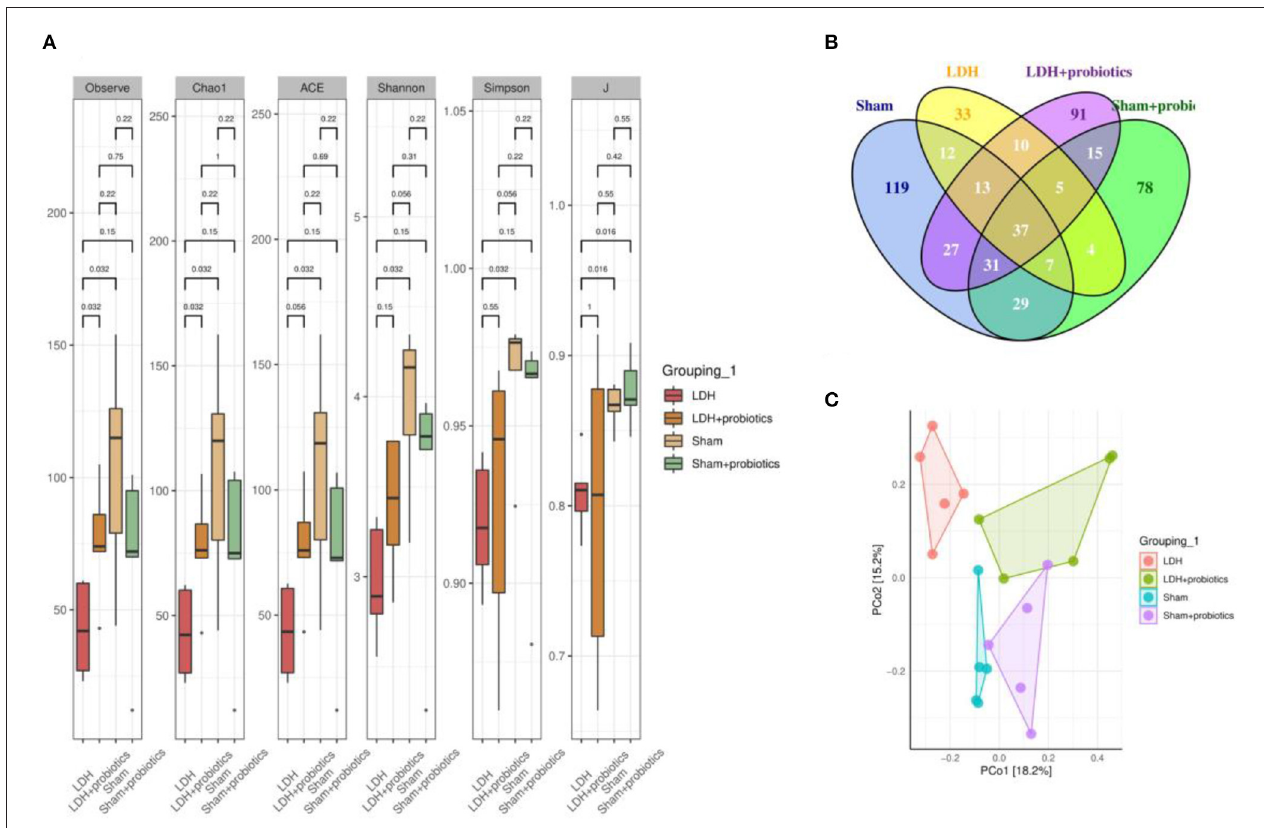
FIGURE 4 | L. paracasei S16 altered gut microbiota. (A) α -diversity; (B) Venn diagram; (C) PCoA. Data were expressed as the mean ±